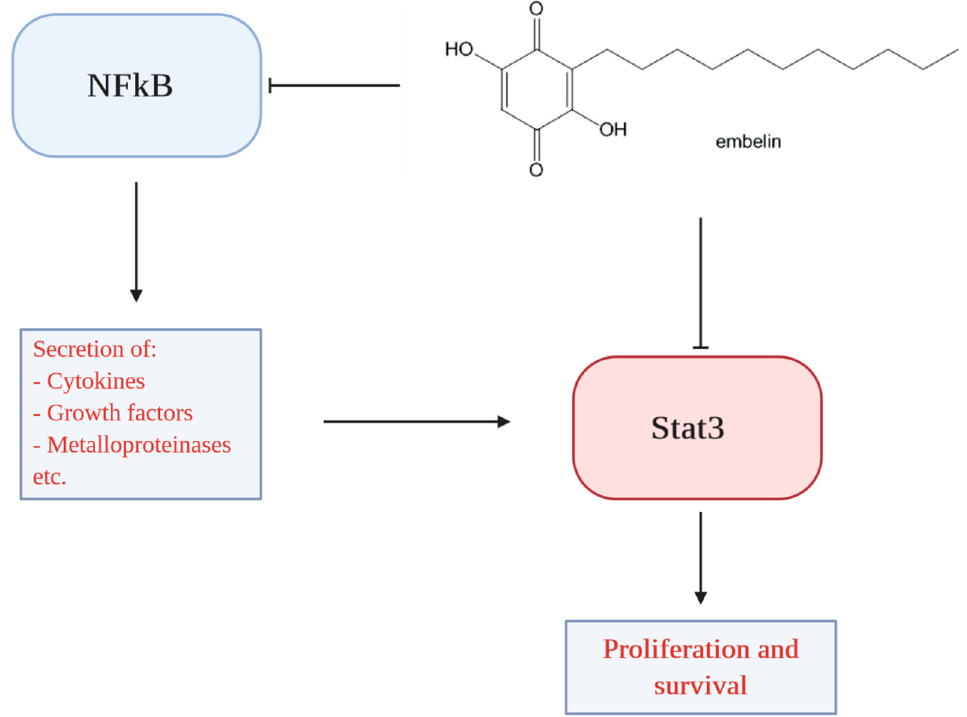
Figure 3. Anticancer effects of embelin. The potent antitumor activity of embelin is linked to various mechanisms, including inhibition of NF- κ B and inhibition of STAT3.